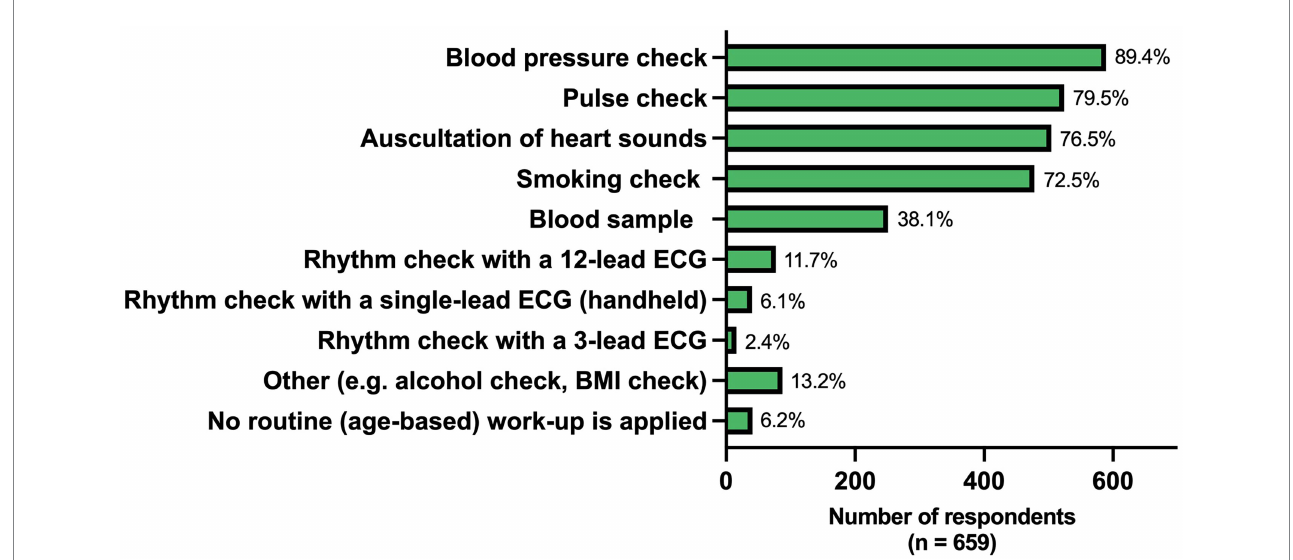
FIGURE 4 Regular health checks performed in patients ≥ 65 years coming for an outpatient visit. ECG, electrocardiogram; BMI, body mass index.